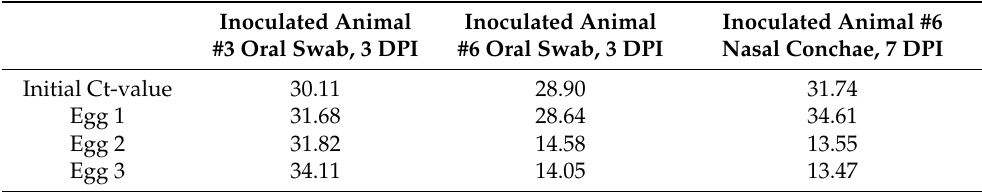
Table 2. Summary of the isolation and propagation experiments of fruit bat samples inoculated with A/bat/Egypt/381OP/2017 (H9N2) in embryonated chicken eggs. Inoculated Animal Inoculated Animal #3 Oral Swab, 3 DPI Initial